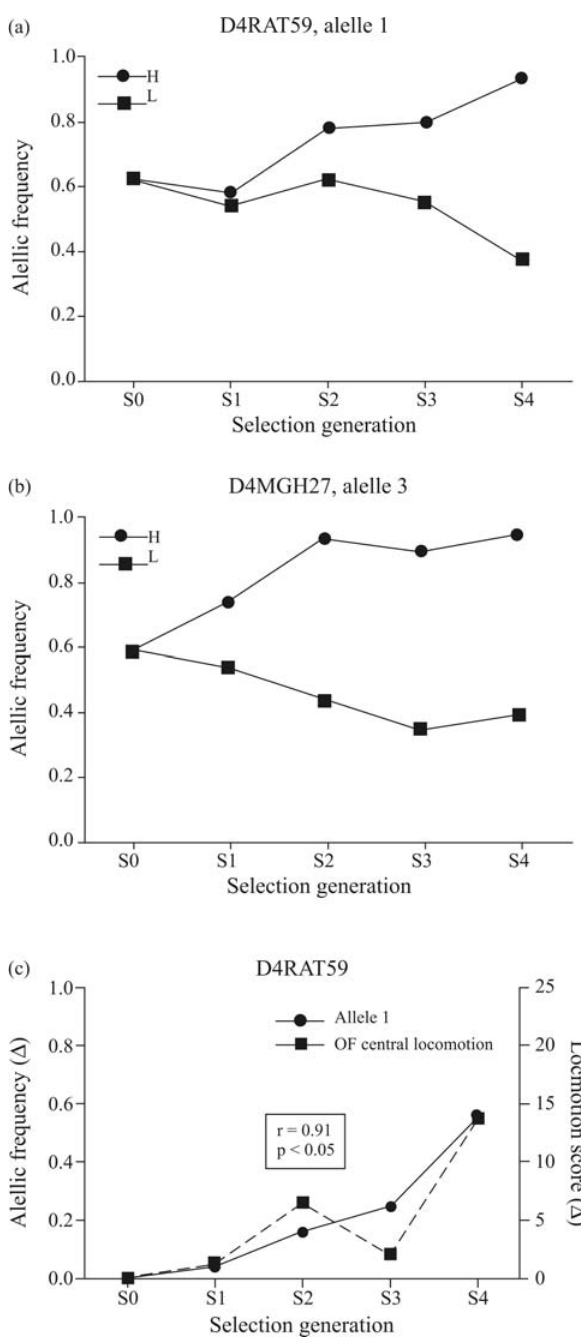
Figure 2 - Comparative frequencies ((a) and (b)) of allele 1 of D4RAT59 andallele3ofD4MGH27betweentheFloripaHandLratlines,fromgen- eration S0 to S4 of selective breeding. Correlation (c) between the differ- encesinbehavioralscoresforcentrallocomotionintheOFtestandthedif- ferences in the frequency of allele 1 of D4RAT59 between the Floripa H and L rat lines. Delta values for both variables were calculated, for each generation, as H – L. A significant correlation was found between the two